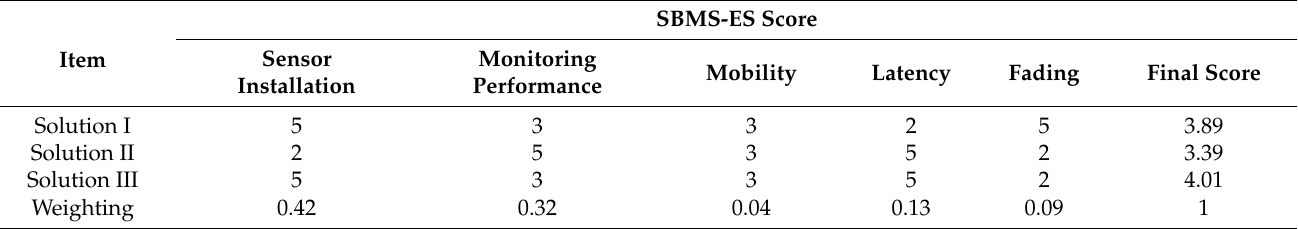
Table 4. Case feature description and